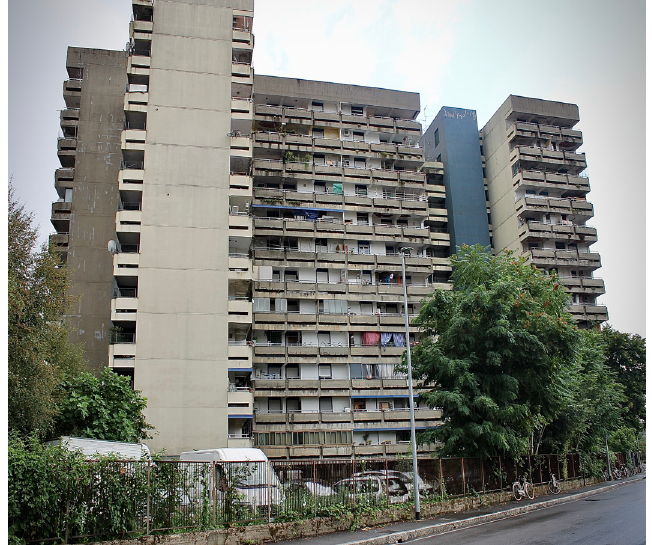
Fig. 15 The building in Via Aquileia, 12, now inhabited only by